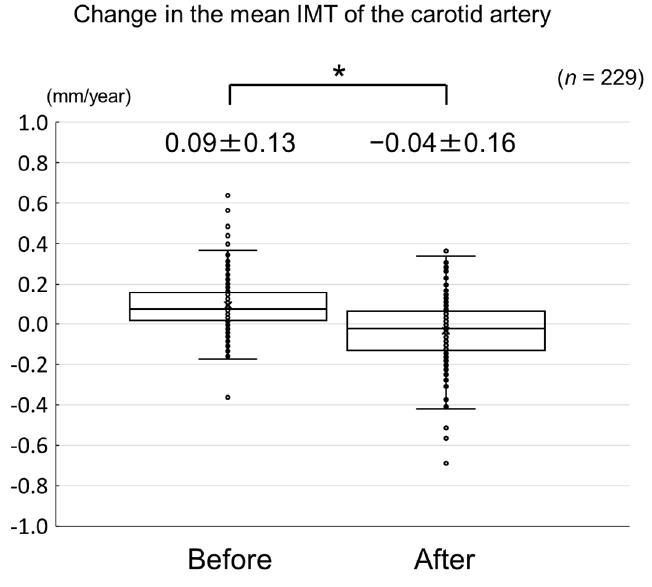
Figure 5. Change in carotid mean IMT during the 12 months before and after the initiation of evolocumab treatment. * p < 0.001.